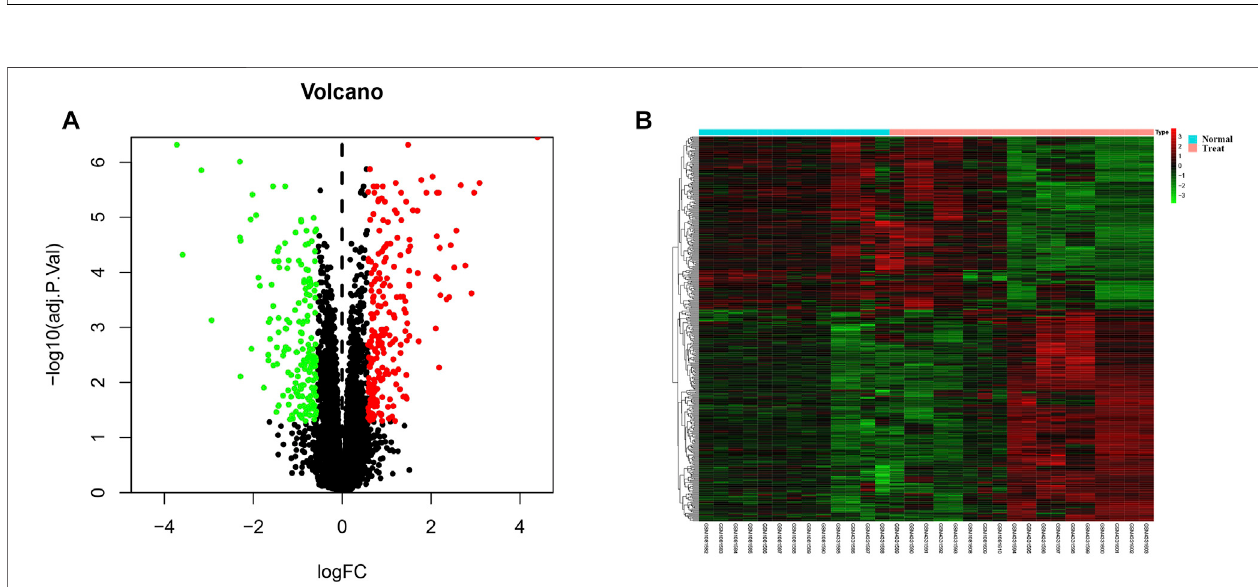
FIGURE 2 | Principal component analysis (PCA) of the gene expression datasets. The points of the scatter plots represented each samples based on the top two principal components (PC1 and PC2) of gene expression pro fi les without (A) and with (B) the removal of batch effect.